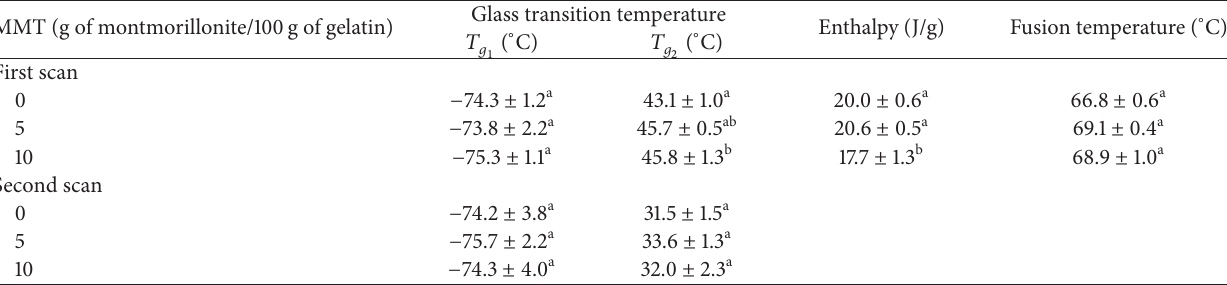
10 − 74.3 ± 4.0 a 32.0 ± 2.3 a Values with different characters differ significantly in the same column ( 𝑝 < 0.05